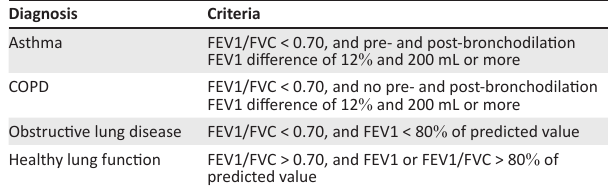
TABLE 2-A1: Spirometry